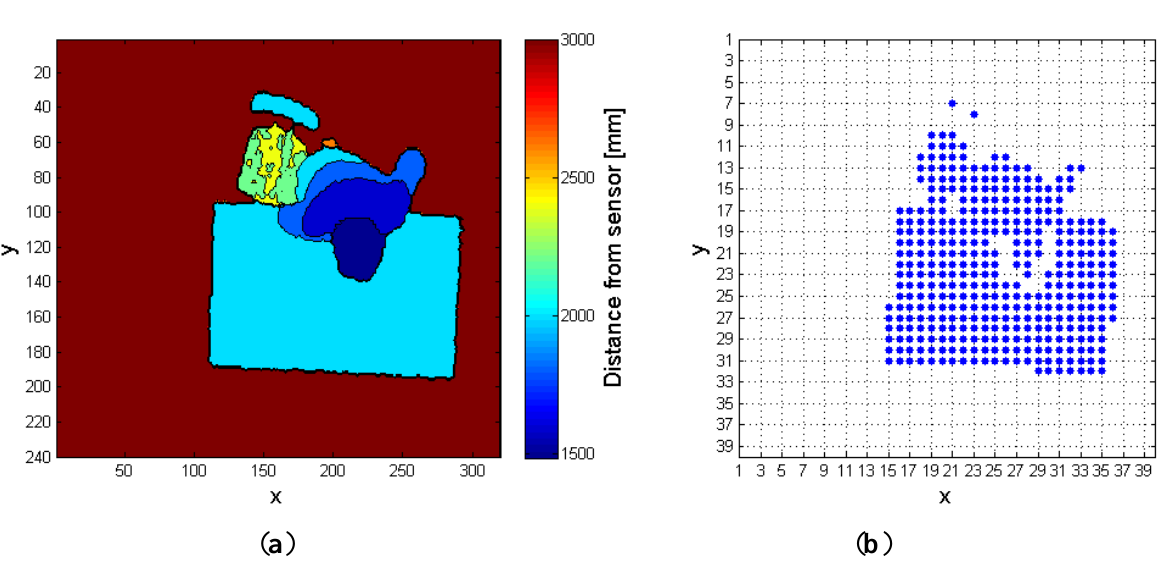
Figure 11. Complex fall with object interaction: ( a ) preprocessed frame, ( b ) corresponding FF frame. When the algorithm avoids using the RF and works on the CF only, the person is merged with the